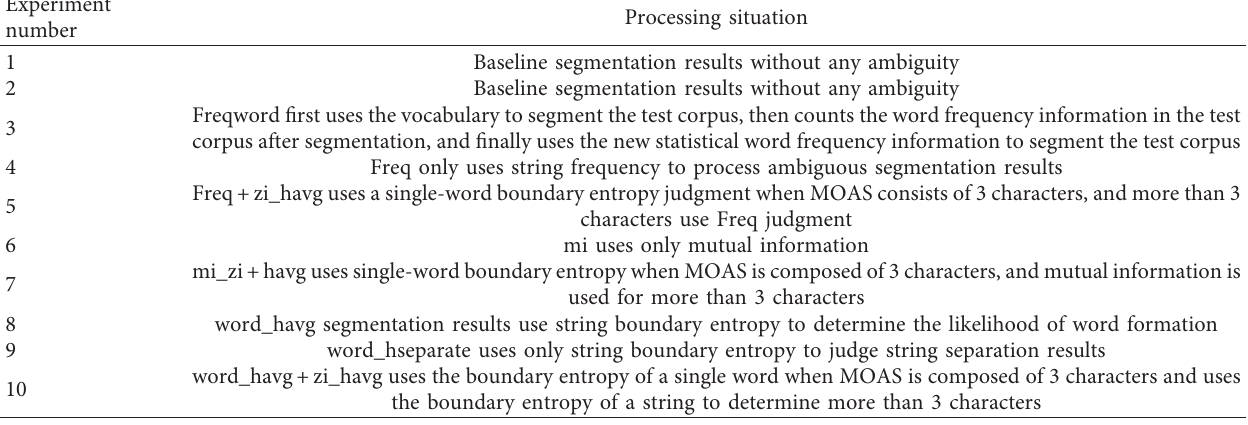
Table 2: Treatment of 10 experiments.